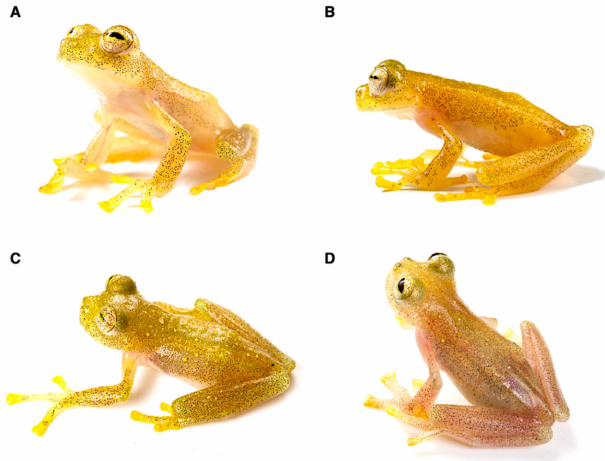
Figure 184. Nymphargus sucre in life. ( A – C ) Adult male, holotype, MZUTI 1421. ( D ) Adult female, MZUTI 1422. Photos by Alejandro Arteaga / Tropical Herping. Obtained from Guayasamin [276].